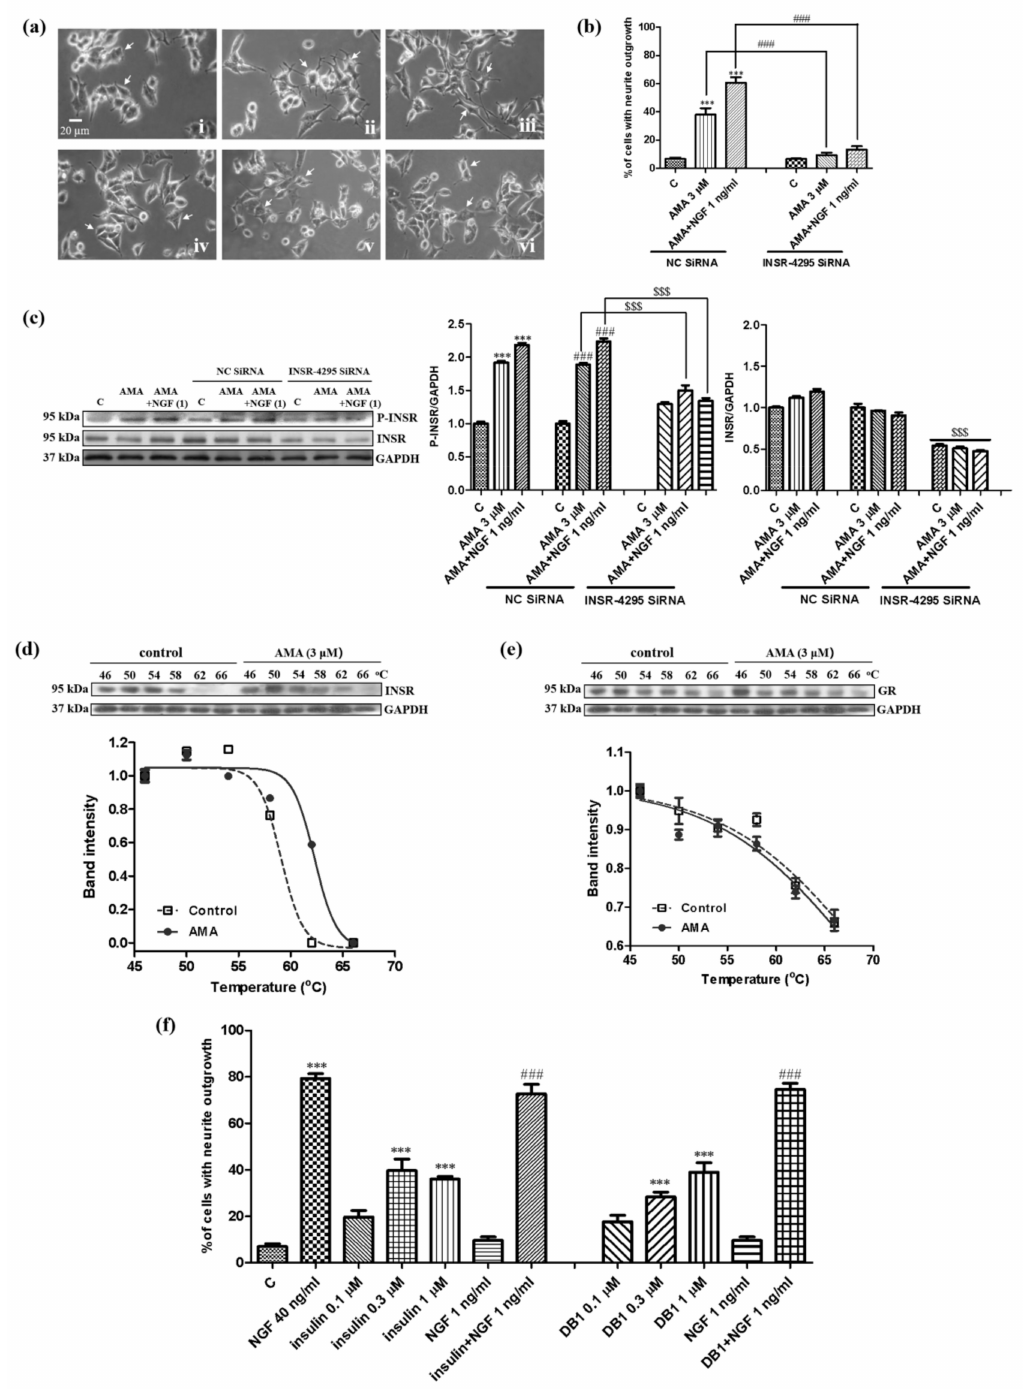
Figure 6. Target prediction of AMA in PC12 cells by using siRNA and a CETSA assay. ( a ) Microphotographs of PC12 cells after treatment with siRNA and AMA or AMA combined with the NGF: ( i ) negative control siRNA, control (0.5% DMSO); ( ii ) negative control siRNA, AMA (3 µ M); ( iii ) negative control siRNA, AMA (3 µ M) + NGF (1 ng/mL); ( iv ) insulin receptor siRNA, control (0.5% DMSO); ( v ) insulin receptor siRNA, AMA (3 µ M); ( vi ) insulin receptor siRNA, AMA (3 µ M) + NGF (1 ng/mL). ( b ) Percentage of cells with a neurite outgrowth after treatment with siRNA and AMA or AMA combined with the NGF. ( c ) Western blot analysis for the insulin receptor after transfection with negative siRNA or insulin receptor siRNA and treatment with AMA or AMA combined with the NGF. Cells were transfected with Lipofectamine 2000 and 150 nM siRNA for 6 h and treated with AMA or AMA combined with the NGF. ( d , e ) CETSA of PC12 cells on the insulin receptor or GR protein and corresponding fitting curves. ( f ) Neuritogenic activity of insulin and demethylasterriquinone B1 in PC12 cells. *** , ### and $$$ indicate significant differences at p < 0.001 compared with the corresponding